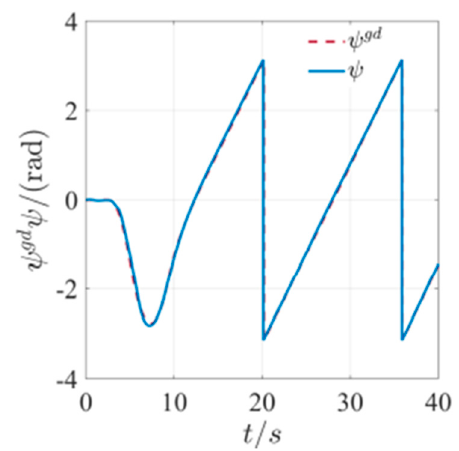
Figure 30. Diagram of the yaw angle of circular tracking.